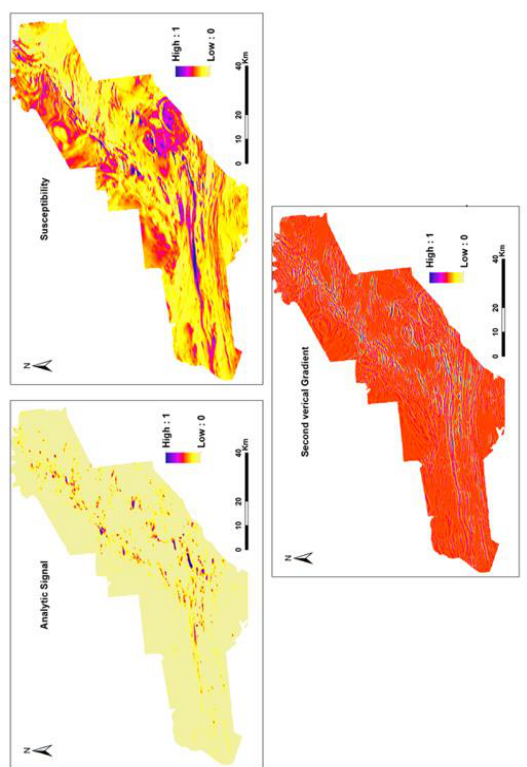
Figure 11. Evidential layers from magnetic data.